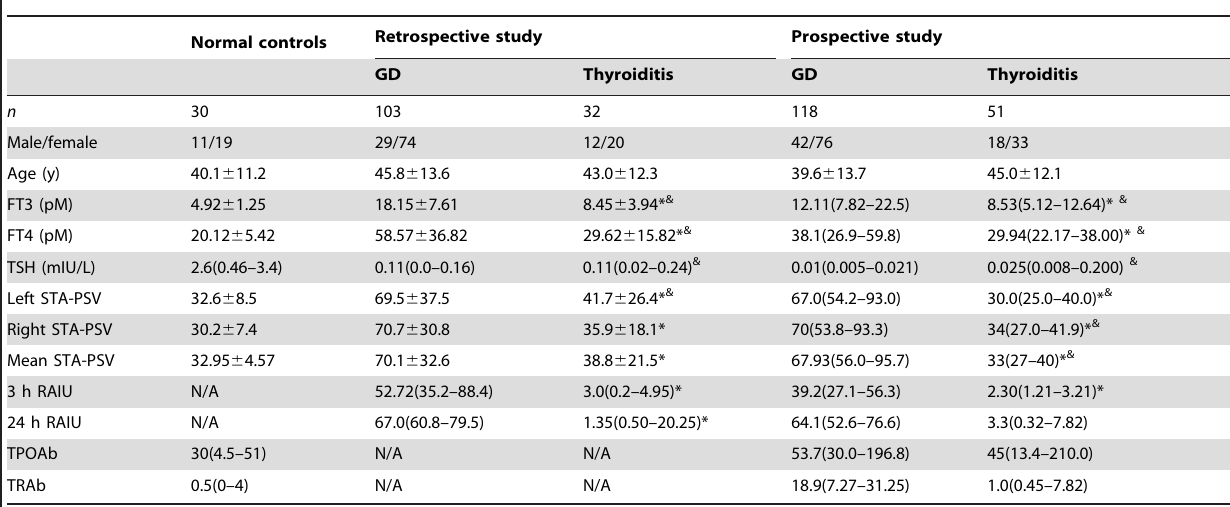
Table 1. General characteristics of the study